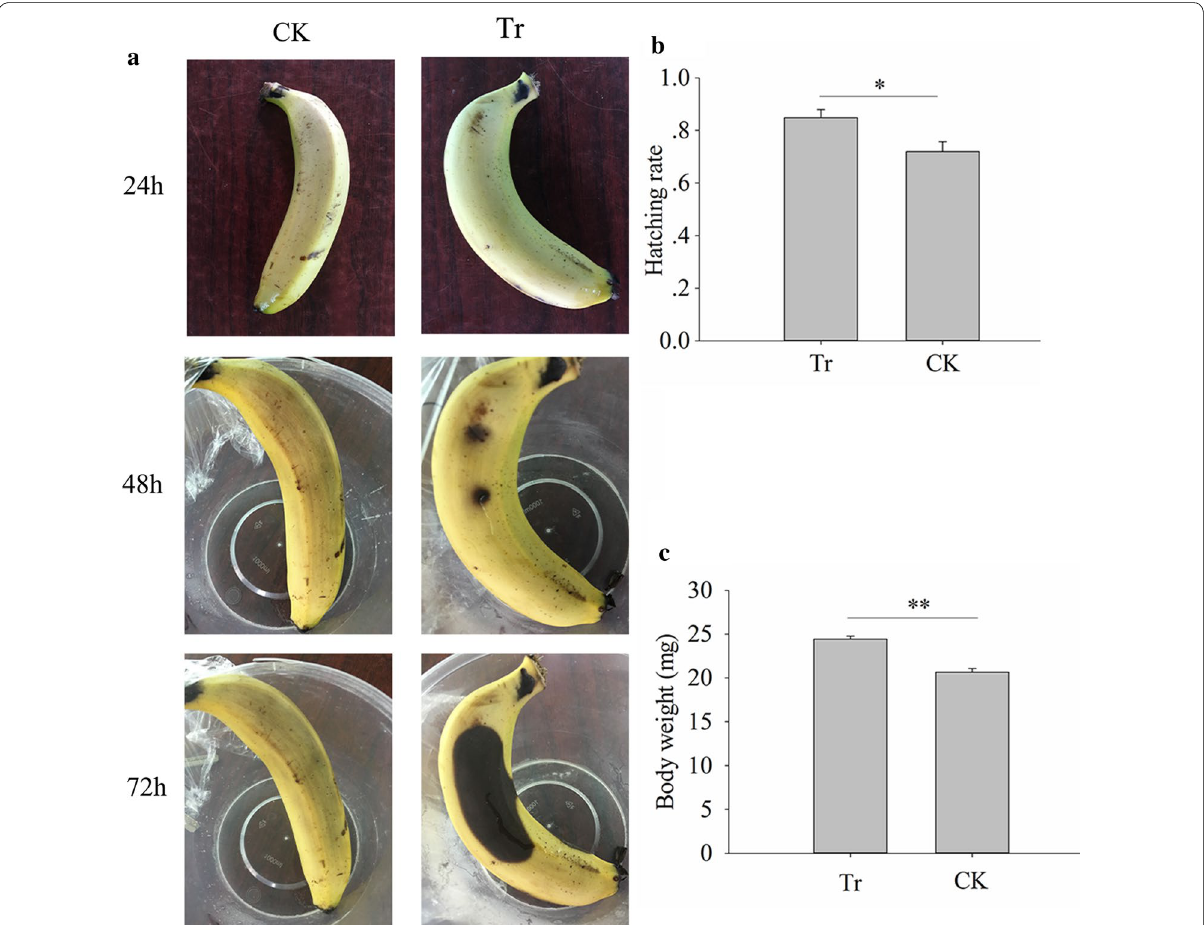
Fig. 6 Effects of Gluconobacter cerinus strain CDF1 on bananas and fly development. a Effect of Gluconobacter sp. on banana. b Effect of Glucono- bacter cerinus strain CDF1 on fly hatching rate. c Effect of Gluconobacter cerinus strain CDF1 on larval body weight. Tr: banana or fly eggs painted with Gluconobacter cerinus strain CDF1; CK: banana or fly eggs painted with sterile water. *p < 0.05; **p <